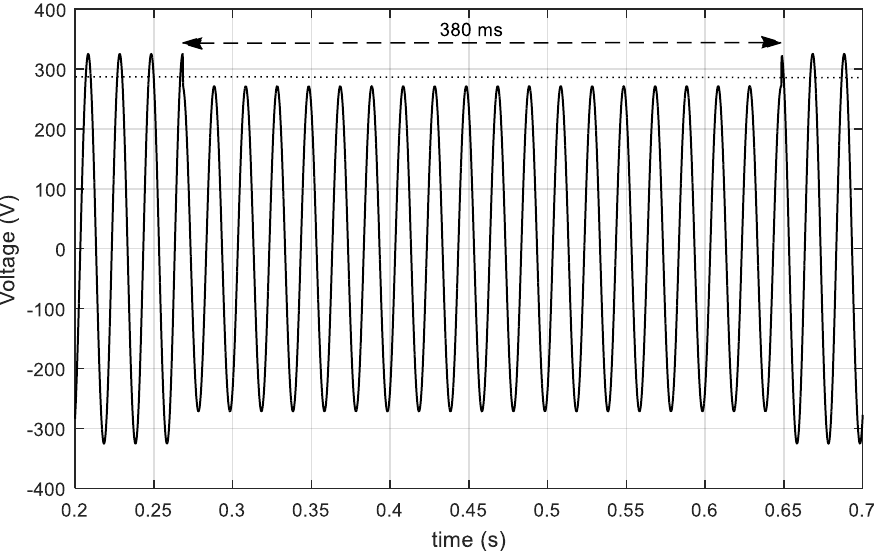
Figure 18. Example of Sag 1 (380 ms 83.5% V NOM ).